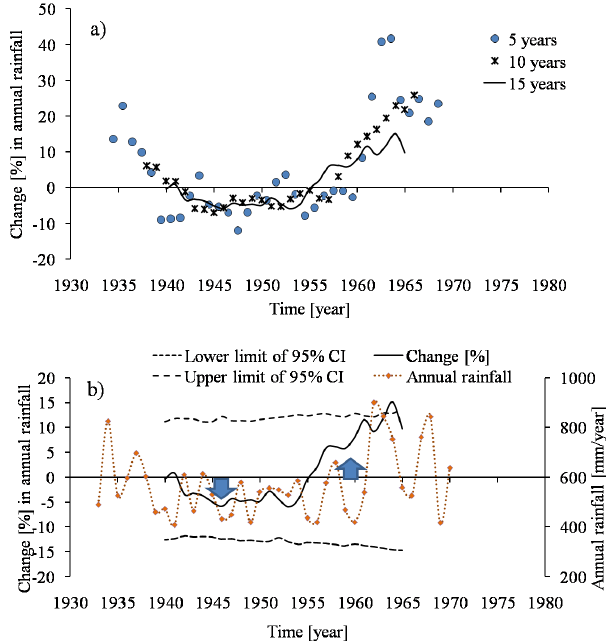
Figure 2. QPM results at station 7 for the period 1935–1970 us- ing time slice(s) (a) considered in sensitivity analysis (5, 10 and 15 years), and (b) selected for the study (15